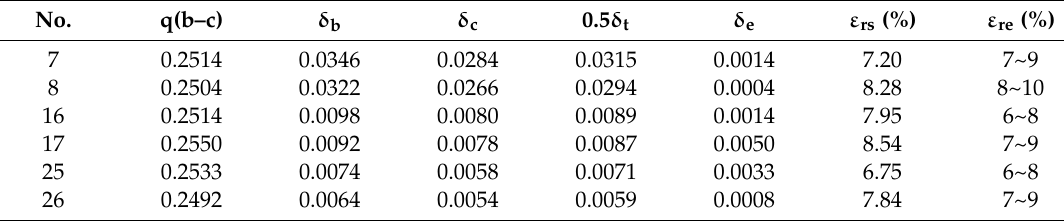
Table 3. Criterion for strain-softening